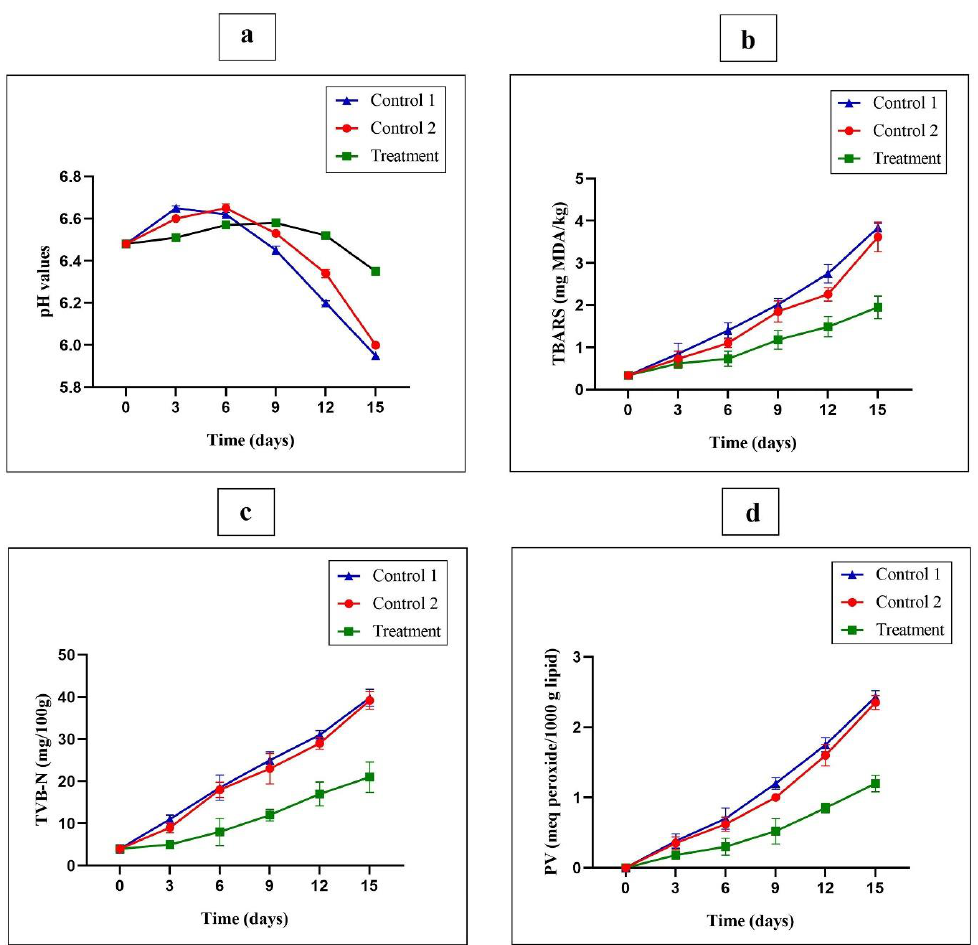
Figure 6. The effects of G/PVA/MEO/CWE films (as treatment), PE films (Control 1) and G/PVA films (Control 2) against the changes of pH ( a ), TBARS ( b ), TVB-N ( c ), and PV ( d ) in the raw turkey breast meat during 15 days of the storage in refrigeration at 4 ◦